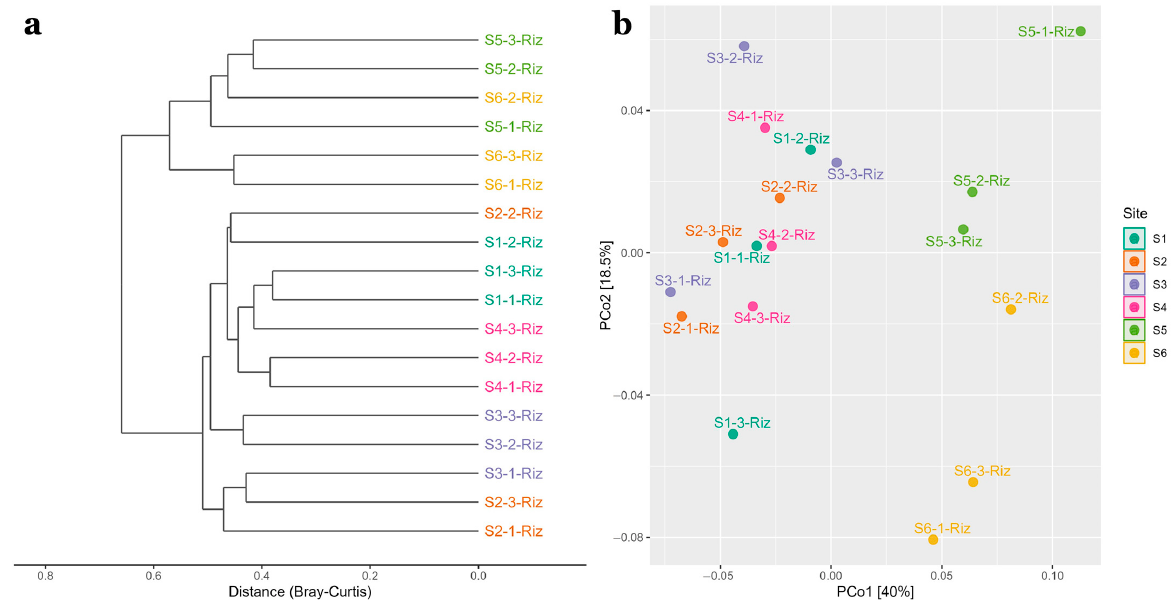
Figure 4. Hierarchical clustering of Bray-Curtis distances for each triplicate of the six sampling sta- tions (S1-S6) ( a ) and PCoA of weighted unifrac distances ( b ) for the same dataset. A color separation by site was applied for both Figures and includes the triplicate data for each site. LEFSE analysis for differentially abundant taxa (species and higher taxonomic ranks) for rhizosphere samples revealed LDA scores of more than 2 points (Figure 5). Deltaproteobacteria ( Desulfobulbaceae family and SEEP-SRB1 genus) were among the taxa with higher LDA scores in sites S5 and S6 along with Pirellulaceae family and Rubripirellula genus (both belonging to Planctomycetes phylum). Acidobacteria ( Subgroup 10 and Subgroup 9 ) and Bacteroidetes ( Aquibac- ter , Portibacter , SJA-28 ) phyla were also differentially abundant for S5 and S6. Figure 5. Differential abundances analysis (LEFSE) at species and upper levels for all sampling sta- tions (S1–S6) using triplicate data for each site. An LDA score threshold = 2 was applied.